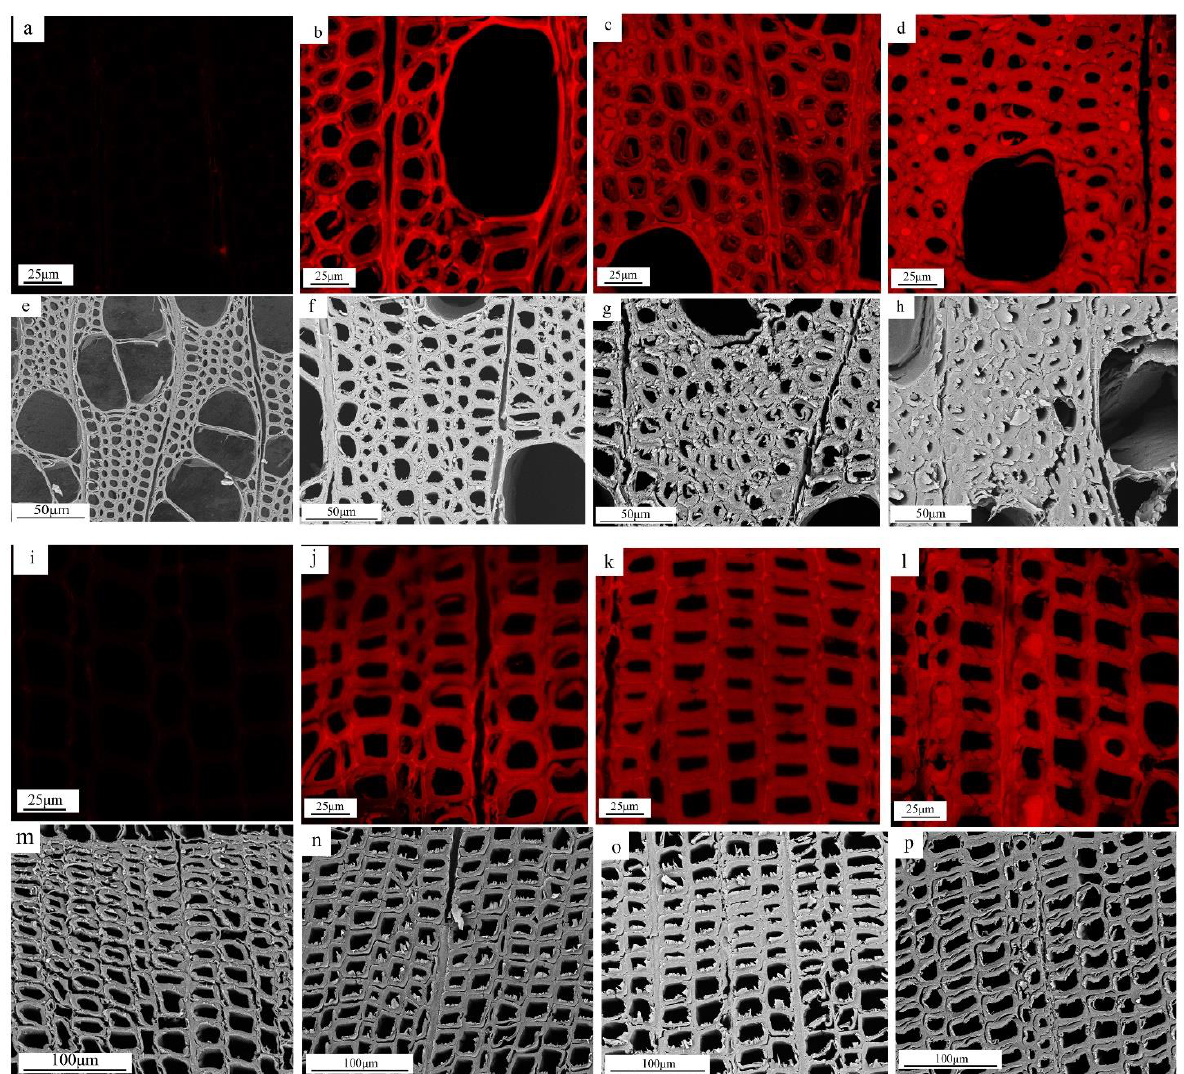
Figure 3. ( a – d ) CLSM images of control poplar wood ( a ), SW23 ( b ), SW45 ( c ), and SW75 ( d ); ( i – l ) CLMS images of control Chinese fir wood ( i ) PW17 ( j ), PW35 ( k ), and PW51 ( l ). ( e – h ) SEM images of control poplar wood ( e ), PW17 ( f ), PW35 ( g ), and PW51 ( h ); ( m – p ) SEM images of control Chinese fir wood ( m ), SW23 ( n ), SW45 ( o ), and SW75 ( p ).